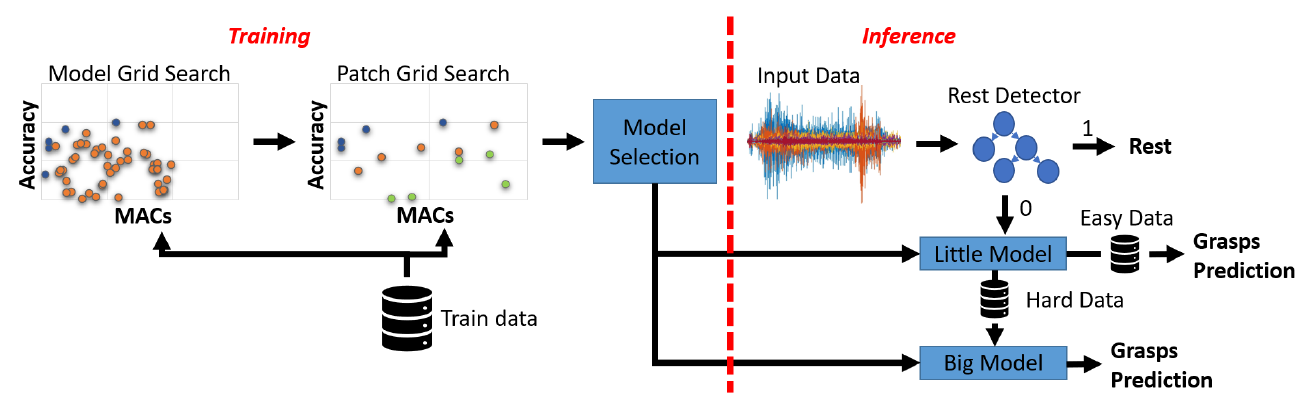
Figure 1. High-level view of the proposed